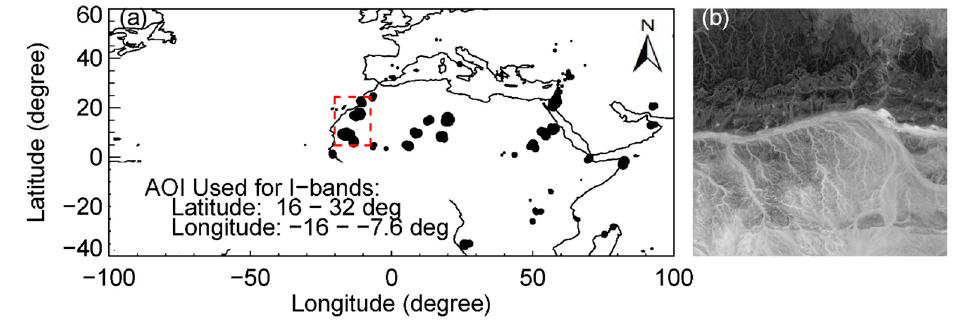
Figure 5. ( a ) Area of interest identified for I-bands geolocation improvement assessment; ( b ) sample Landsat chip within the area of interest.